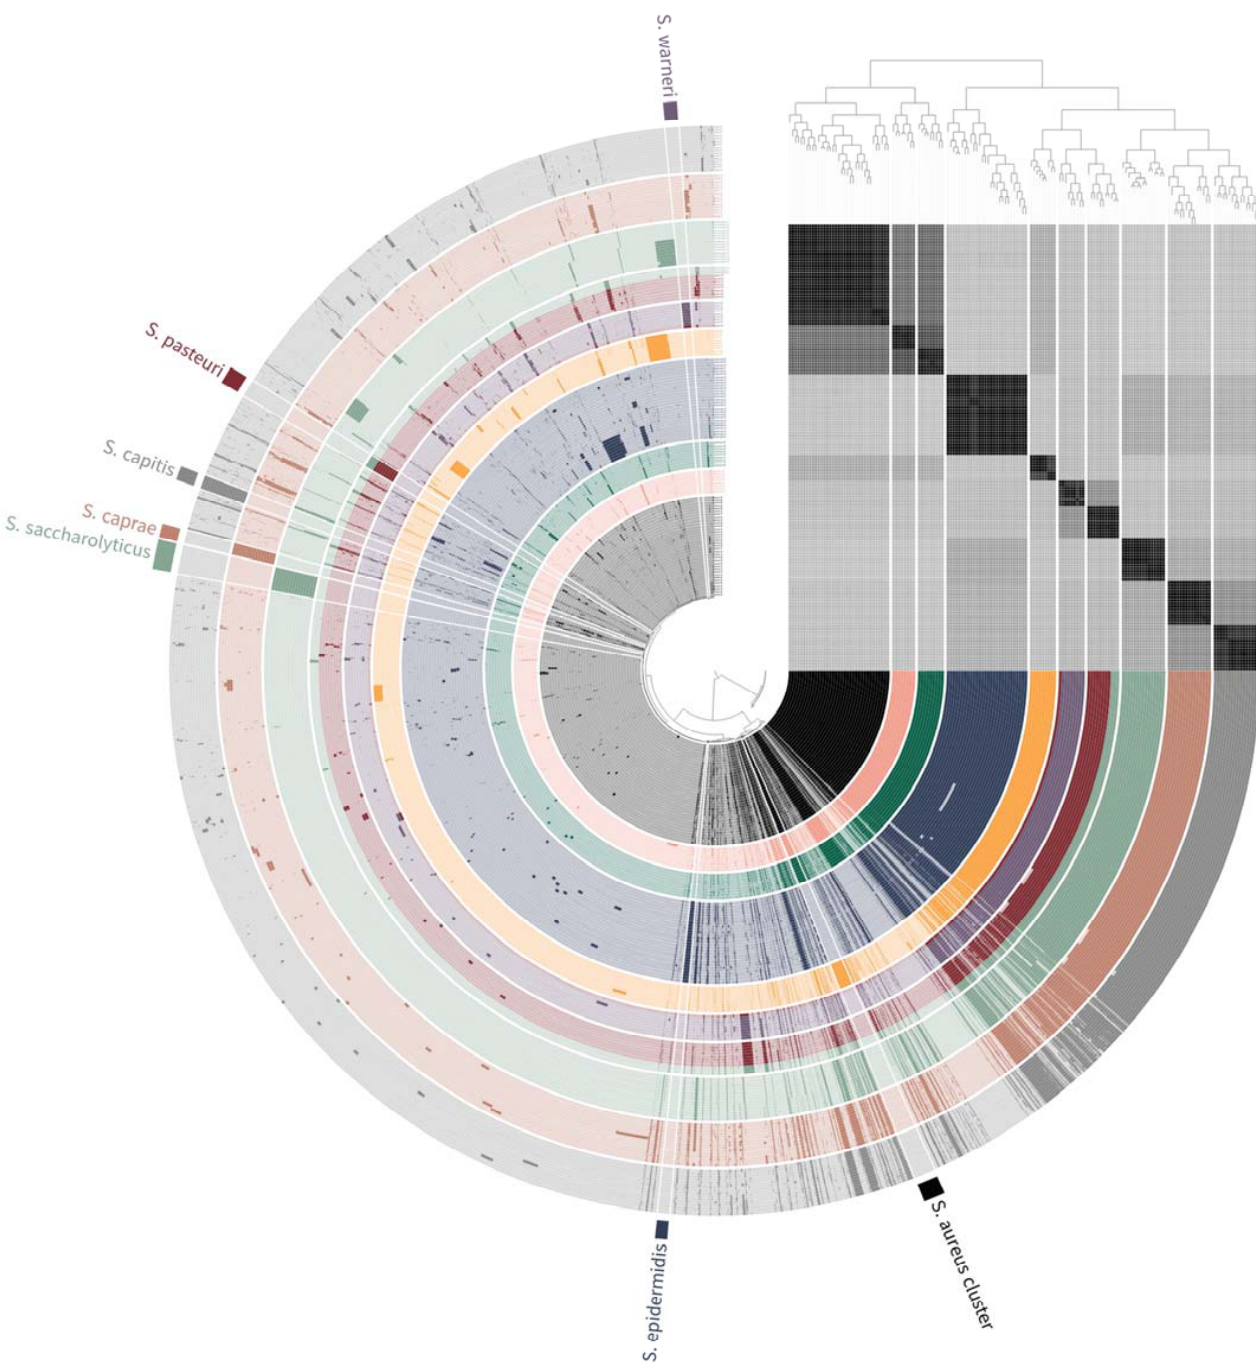
Figure 1. Pan-genome analysis generated with Anvi’o software (version 7.0) for 155 staphylococci genomes. The layers represent individual staphylococci genomes organized by their phylogenomic relationship. In the layers, the dark and bright areas within the bars indicate the presence and absence of genes, respectively. The ANI values are represented by a heatmap determined at high (black) and low (gray)